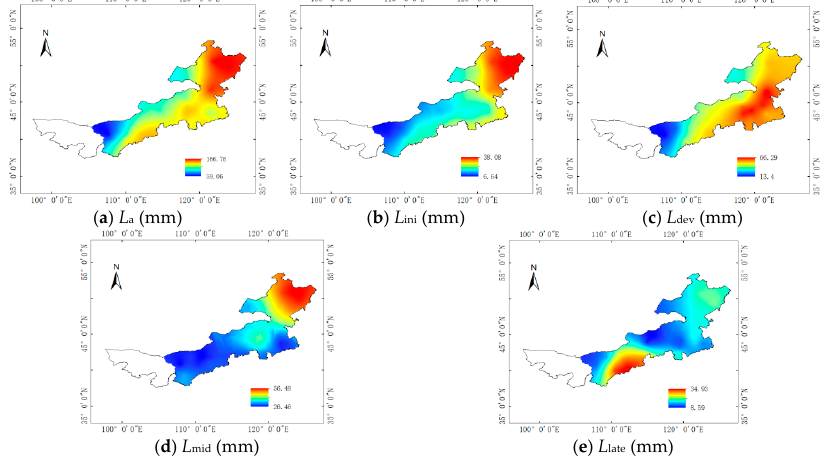
Figure 2. Spatial variation characteristics of effective precipitation ( P e ) during the entire growth period ( a ), early growth period ( b ), rapid growth period ( c ), middle growth period ( d ), and end growth period ( e ) of maize from 1959 to 2018.